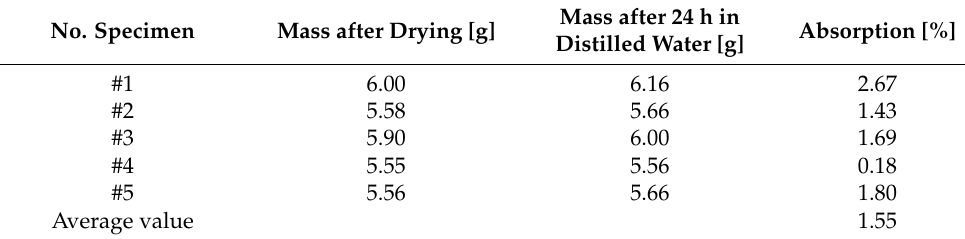
Table 2. Distilled water absorption of Ecoflex 00-30 test specimens.